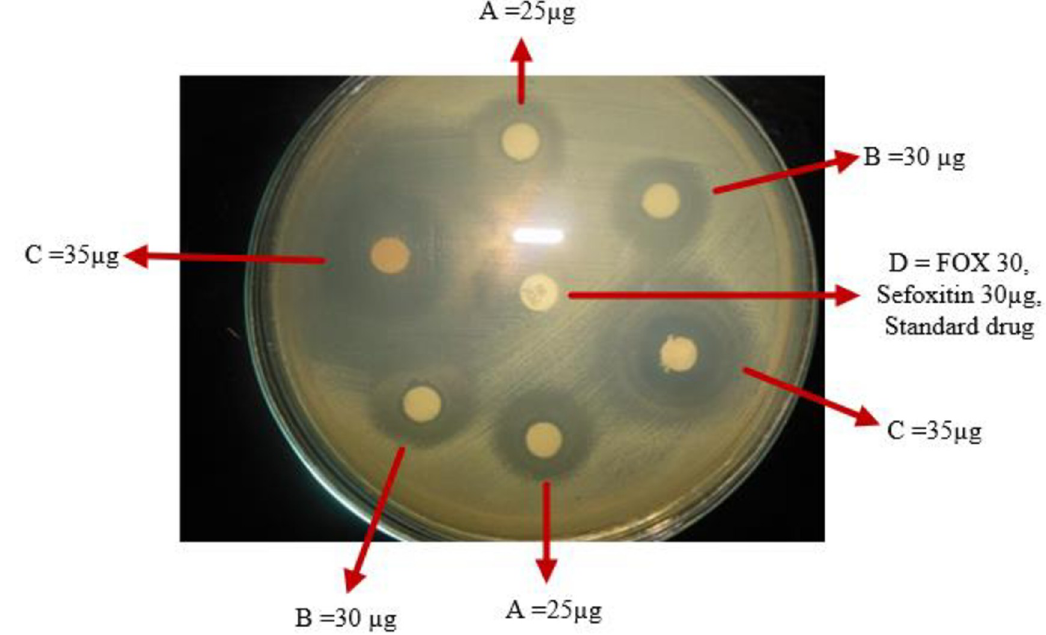
Fig 1. Antibacterial effect of Cirsium englerianum on MRSA in different doses.